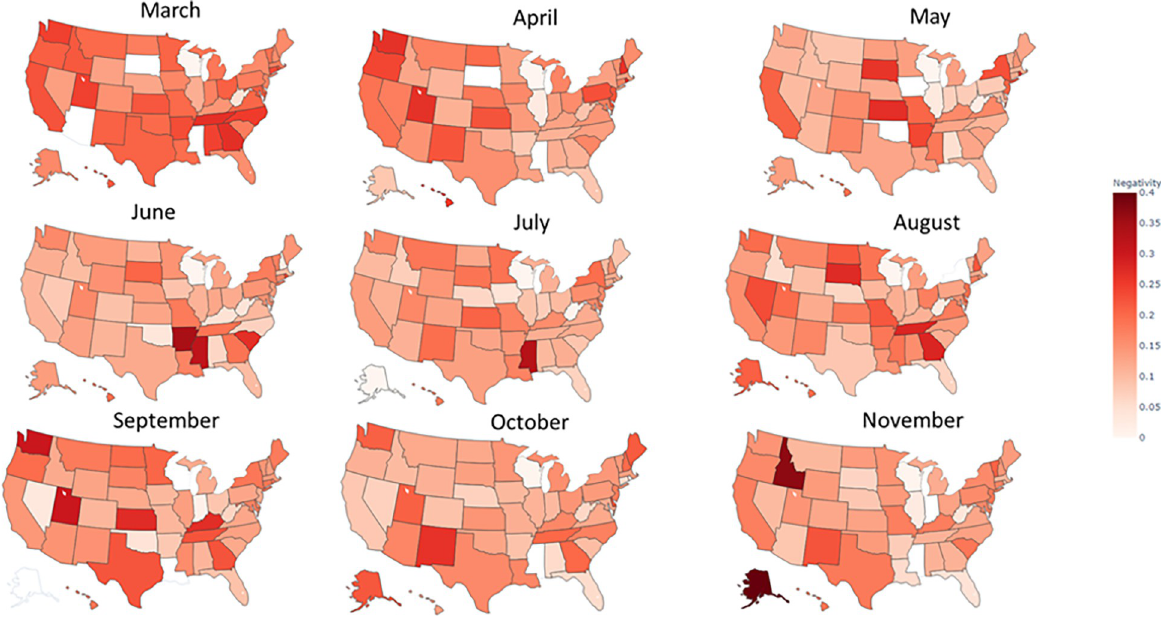
Fig 5. State–level evolution of tone (sentiment) during the study period: Evolution of negativity.